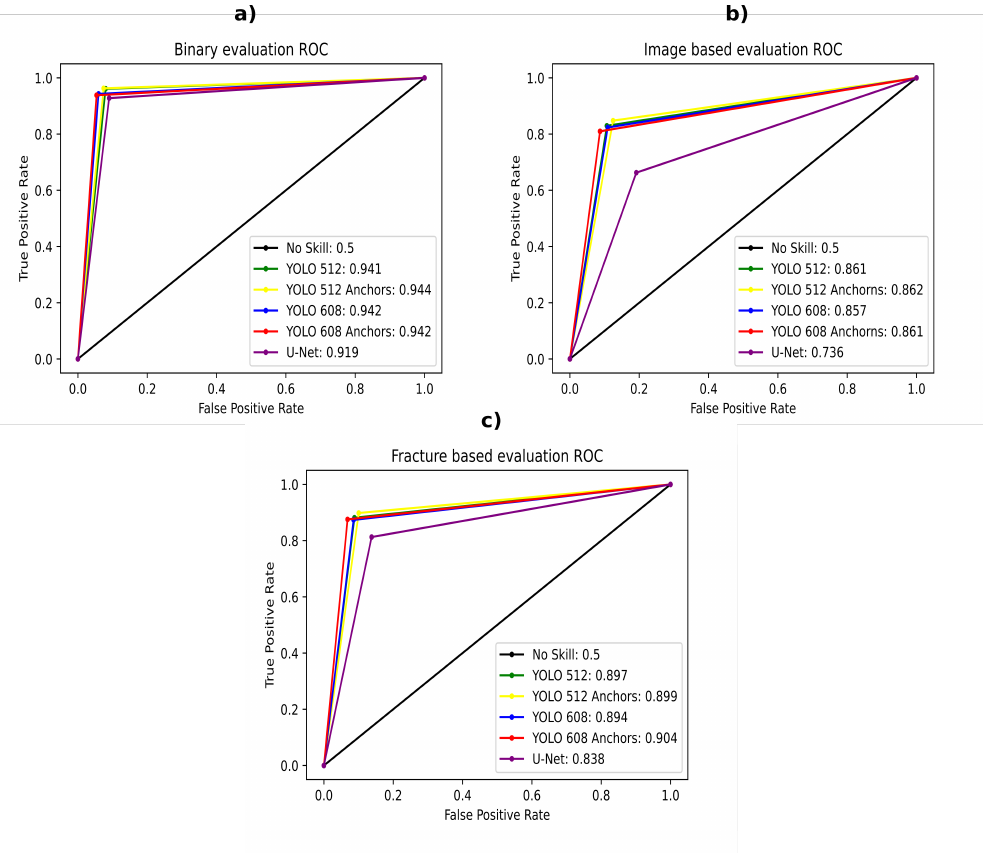
Figure 5. ROC for the evaluations. In the legend of each subfigure, the AUC-ROC is presented for every model. ( a ) ROC for binary evaluation, ( b ) image-based evaluation, and ( c ) fracture-based